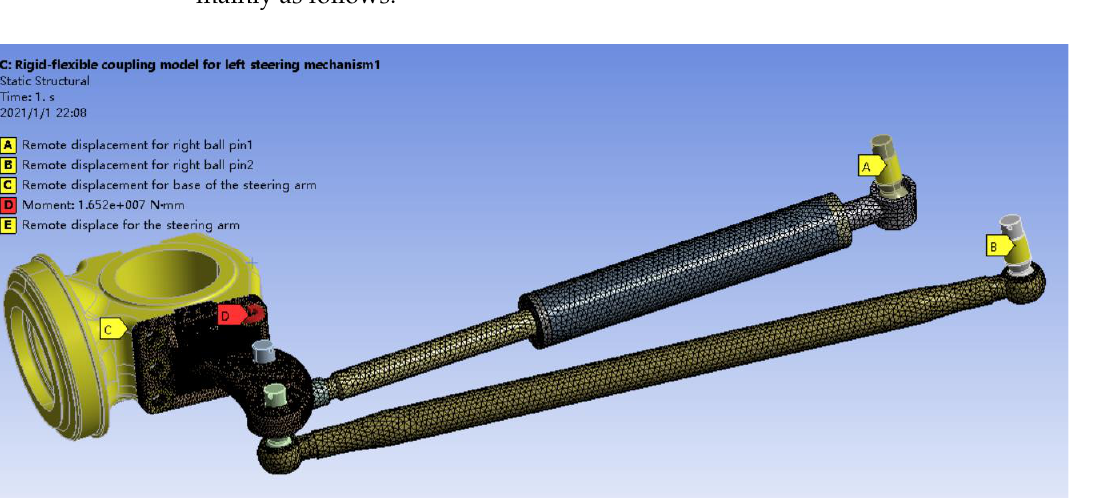
Figure 9. Von Mises stress distribution on the steering arm. 5. Stress Test and Its Discussions 5.1. Test Arrangement On the one hand, the stress test is performed to understand the forces on parts and realize a better design for mining trucks. On the other hand, the stress test can verify the modelling results from the fast calculation method for the steering arm. The stress points and the test road in the experiment are shown in Figures 10 and 11, respectively. Different test points on parts, such as the steering arm, assembled steering cylinder, and assembled tie rod, are arranged. These points include three- and single-axis strain gauges, and there are, in total, 35 channels. In the test road, the height of the obstacle is arranged as 200 mm,